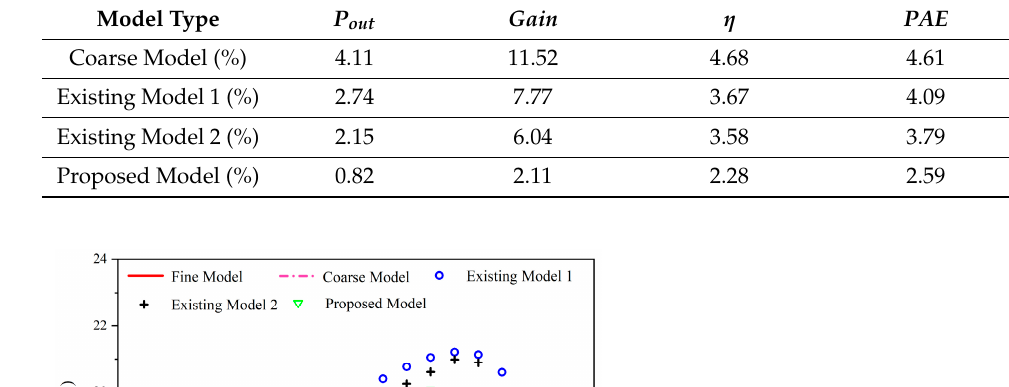
Table 2. HB simulation results of the four models.